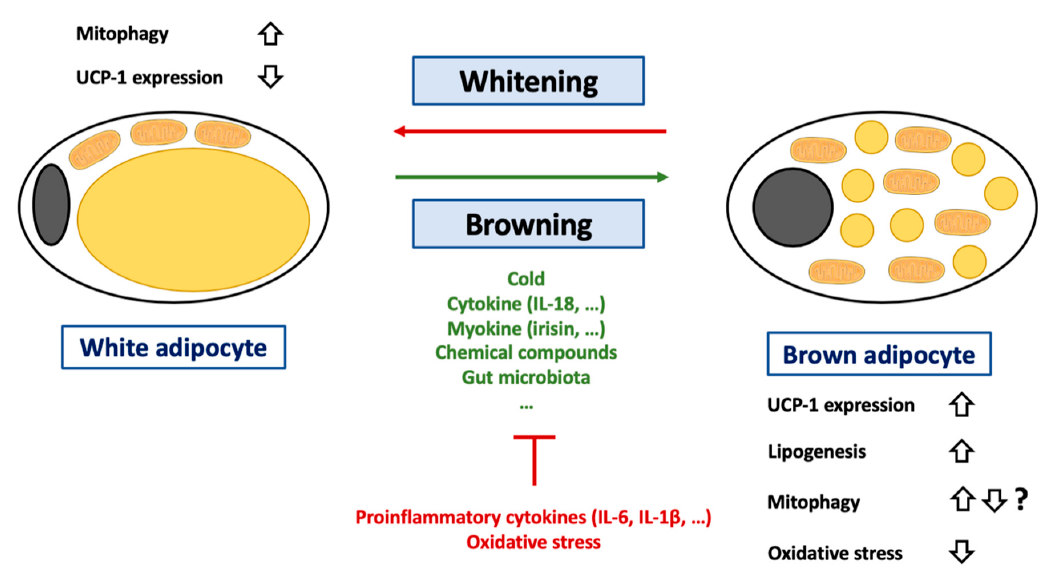
Figure 4. Regulation of browning of white adipocytes. Abbreviations: IL (Interleukin), UCP-1 (Uncoupling Protein-1). White adipocytes are a cell-type specialized in lipid storage but also characterized by an important endocrine function. These cells are characterized by an unilocular lipid droplet and a reduced mitochondrial mass. During the last decades, it was demonstrated that these cells could transdi ff erentiate into brown adipocytes under certain circumstances such as cold exposure, change in gut microbiota (decrease in Firmicutes level) or exposition to cytokine (such as IL-18), myokine (such as irisin) or chemical compounds (such as retinoic acid). This process can be inhibited by several conditions including exposition to proinflammatory cytokines such as IL-6 or IL-1 β or to oxidative stress. A more detailed list of pro / anti-browning conditions can be found in the main text. The adipocyte browning is characterized by an increase in lipogenesis and changes in terms of lipid droplet number and composition. The hallmark of adipocyte browning is the induction of UCP-1 expression. Of note, if it is considered that adipocyte browning is accompanied by UCP-1 activation, it was recently suggested that UCP-1 could also play a key role in lipid metabolism. Activation of UCP-1 is often accompanied by a decrease in oxidative stress in adipose tissues. Brown adipocytes can also di ff erentiate into white adipocytes. This process, named adipose tissue whitening, is accompanied an increase in mitophagy in order to clear cells from UCP-1 expressing